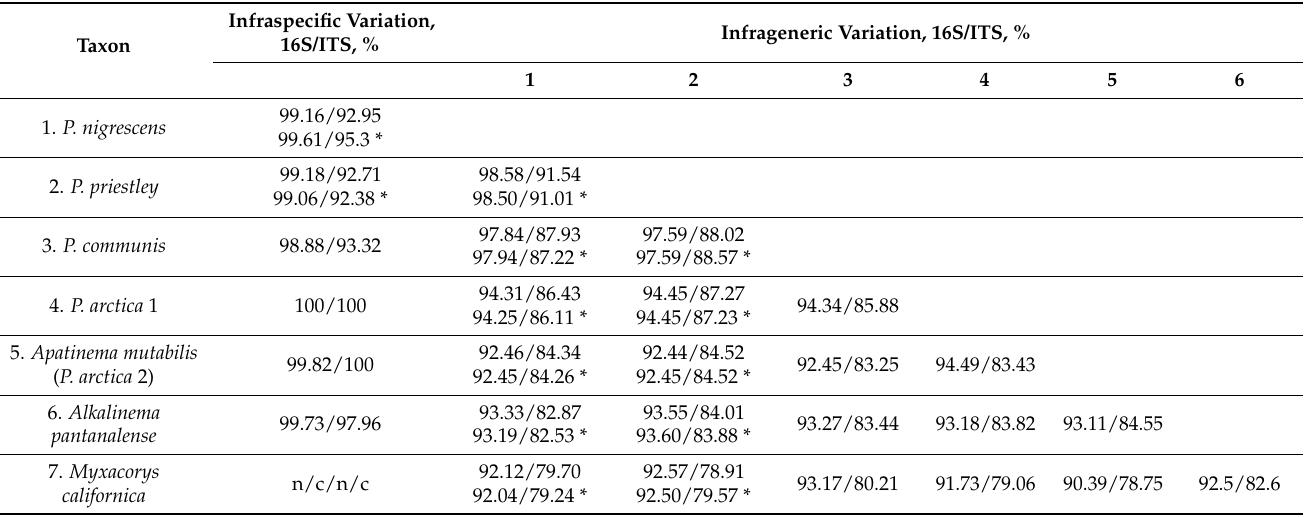
Table 2. The level of infraspecific and infrageneric variation for the genus Phormidesmis , based on 16S gene and ITS sequence data, % 1